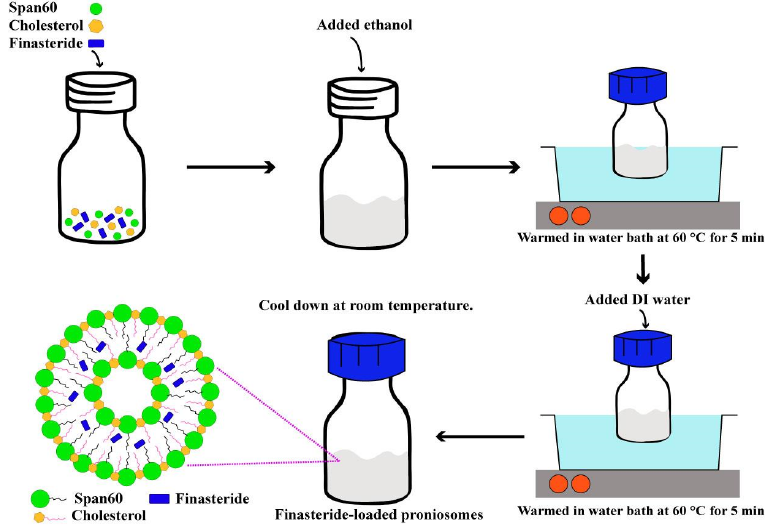
Figure 1. The schematic representation of the preparation of FLP.